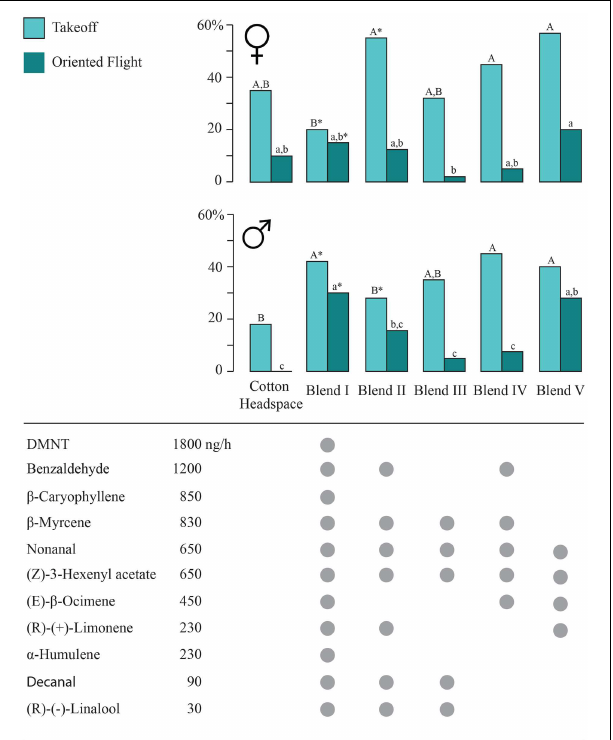
FIGURE 2 | Flight response of Spodoptera littoralis females and males to sprayed cotton headspace, and synthetic blends using a piezoelectric sprayer in a flight tunnel assay. Headspace was released at 1800 ng/h of the main compound DMNT. Gray circles indicate which compounds are included in each blend. Different letters indicate statistical differences between the blends, and asterisks indicate treatments which differ between males and females. A generalized linear model (GLM) with a Bernoulli binomial distribution and post-hoc Wald pairwise comparison tests were used to identify differences between treatments ( N = 50